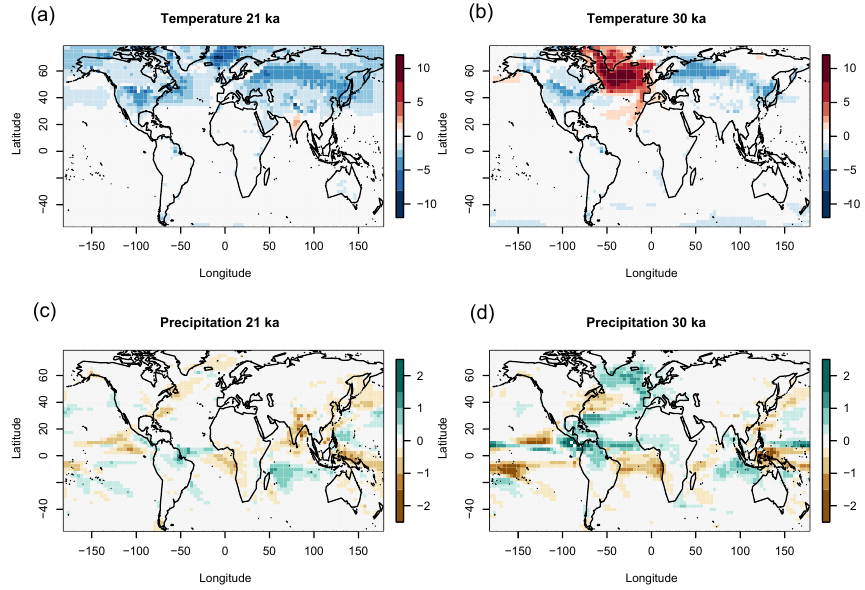
Figure 3. Anomaly of (a) and (b) temperature at 1.5m (degrees Celsius); and (c) and (d) precipitation (mmday − 1 ); between the Dynamic vegetation simulation and the equivalent Static vegetation simulation. For (a, c) 21ka and (b, d) 30ka. The pattern of increased temperature at 30ka is similar to the pattern at 56 and